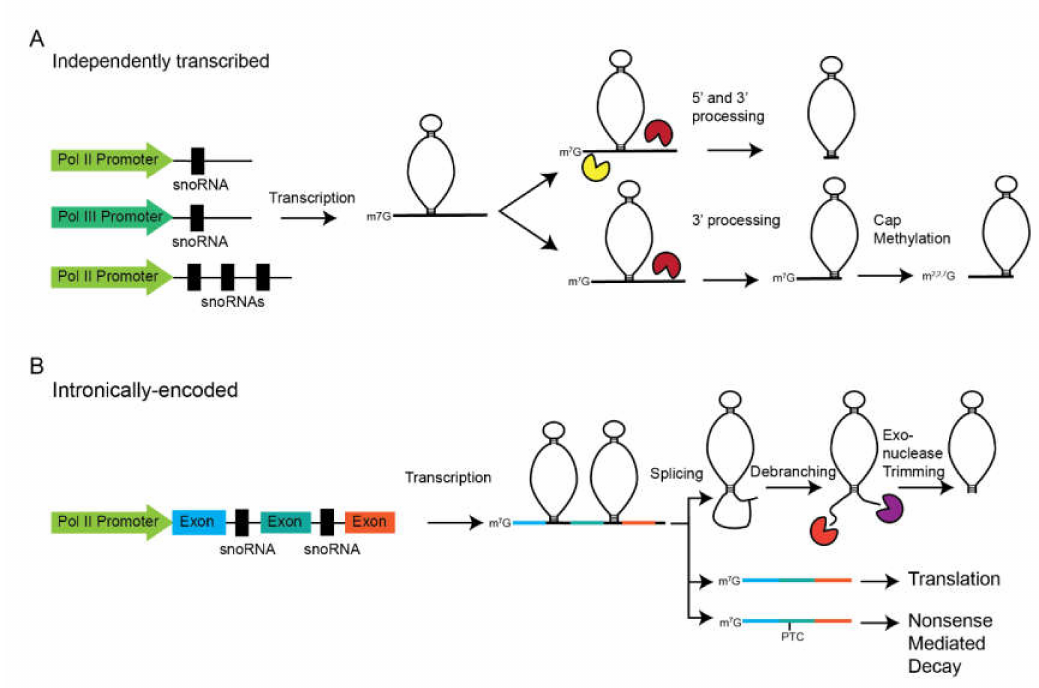
Figure 3. SnoRNA processing pathways. SnoRNAs are either independently transcribed or intronically encoded. ( A ) Independently transcribed snoRNAs exist as mono- or polycistronic units that are transcribed by RNA polymerase II or III. A trimethylguanosine (m 2,2,7 G) cap can be added or the 5 (cid:48) end can be cleaved o ff . The 3 (cid:48) end processing is required for final maturation of both capped and uncapped snoRNAs. ( B ) Intronically encoded snoRNAs are transcribed by RNA polymerase II from the promoters of their host genes. The host gene can encode a functional protein or a noncoding transcript that is often degraded by nonsense-mediated decay due to the presence of a premature termination codon (PTC). Maturation of the snoRNA requires mRNA splicing and debranching of the snoRNA-containing intron followed by exonucleolytic trimming. We presented Box C / D snoRNAs, but Box H / ACA snoRNAs undergo the same maturation